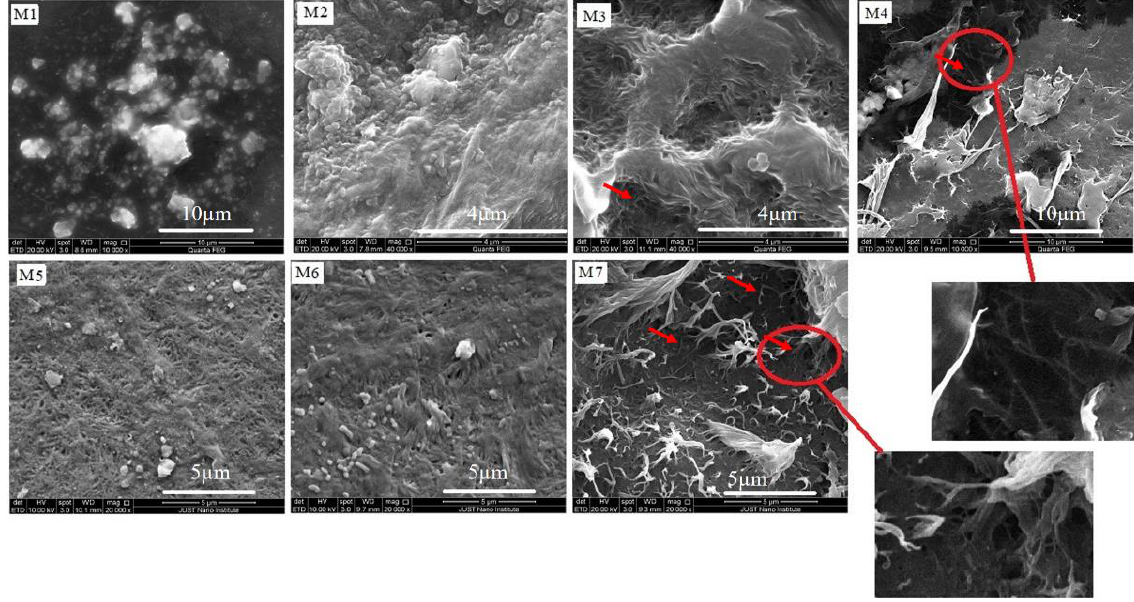
Figure 7. Scanning electron microscope images of M1 – M7 showing the embedding of CNTs in the polymeric matrix.